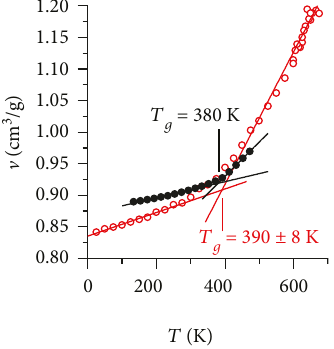
Figure 6: Calculated (Box#4, empty circles)) and experimental (full black circles) evolution of the speci fi c volume v of the polymer as a function of